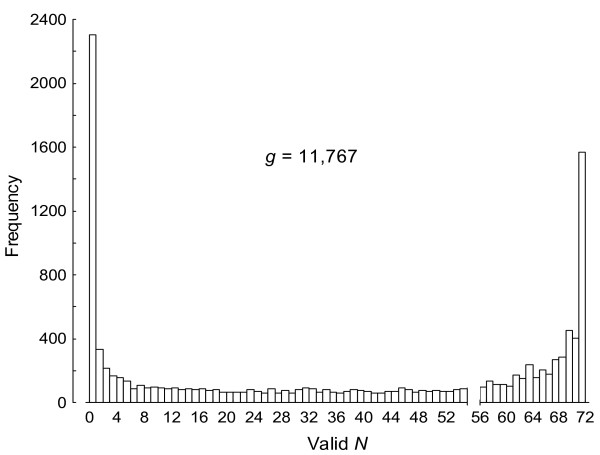
Distribution of valid gene expression levels. For a given probe g the maximum number of valid gene expression values for each thermal selection regime was N = 72. All probes with N < 57 (left part just before the x-axis scale break) were excluded from the statistical analysis.